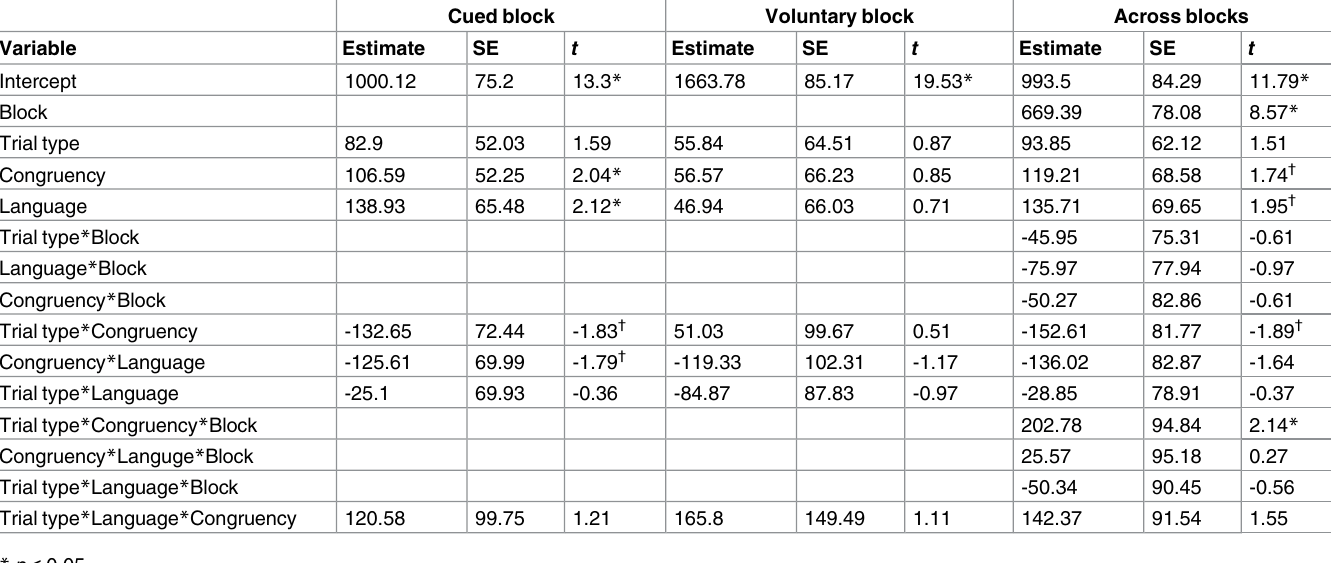
Table 8. Results on Naming latency in cued and voluntary block (Experiment